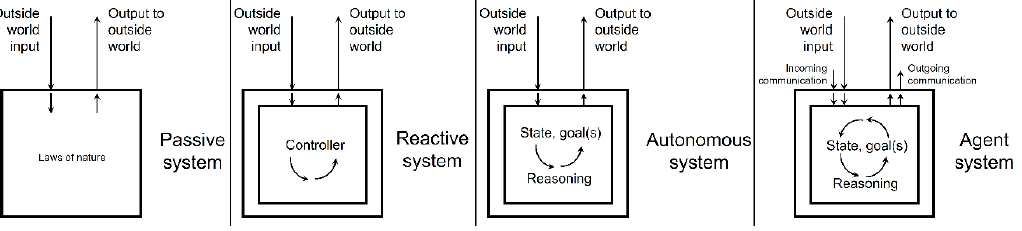
Figure 1. Increasing degrees of interaction in buildings. In Figure 1 the box indicates the system; ingoing arrows are percepts and communications from the outside world; outgoing arrows are actions and communications to the outside